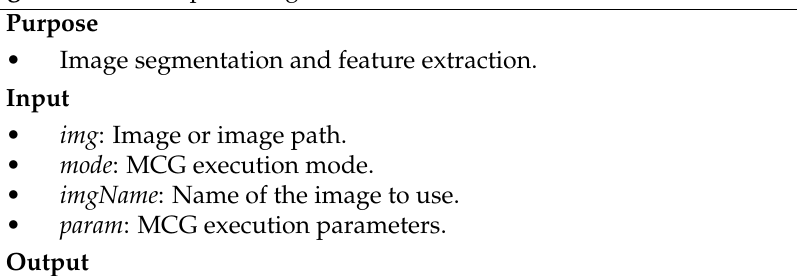
Algorithm A3 is in charge of initializing the execution parameters of the GBVS and executing it. The default parameters of the algorithm (1) are stored in param . Next, the channels (dimensions for the GP) to be used are chosen (2). The Gabor angles to use, the subsampling levels, the tolerance level of the eigenvector equilibrium mechanism, and the minimum subsampling size are established (3–6). The individual generated by the GP is result for the input image (10).